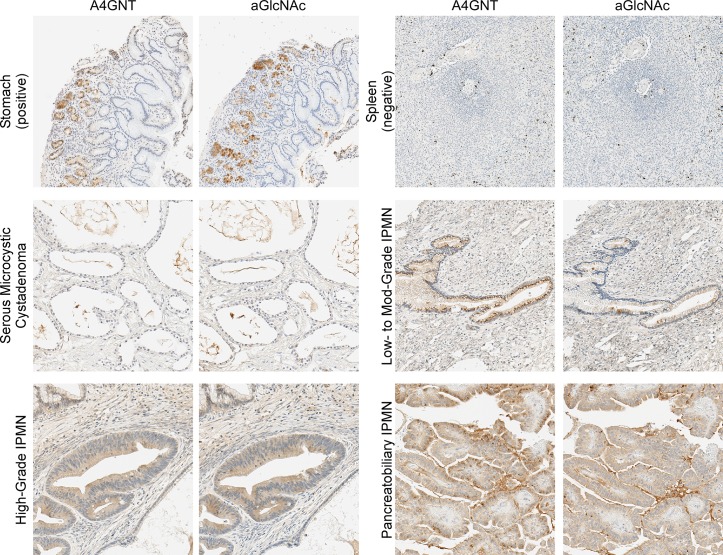
Correlated expression of A4GNT and αGlcNAc in the dysplastic epithelia of mucinous cysts.We stained adjacent sections of each block with anti-A4GNT or anti-αGlcNAc. The 2 antibodies showed strong similarity in their staining. Glandular cells of the stomach were strongly and mulitfocally positive. Spleen cells were negative with the exception of scattered resident macrophages. The staining of cystic epithelia was low in a non-mucinous cyst and high in mucinous cysts, particularly in high-grade dysplasia and pancreatobiliary IPMN.